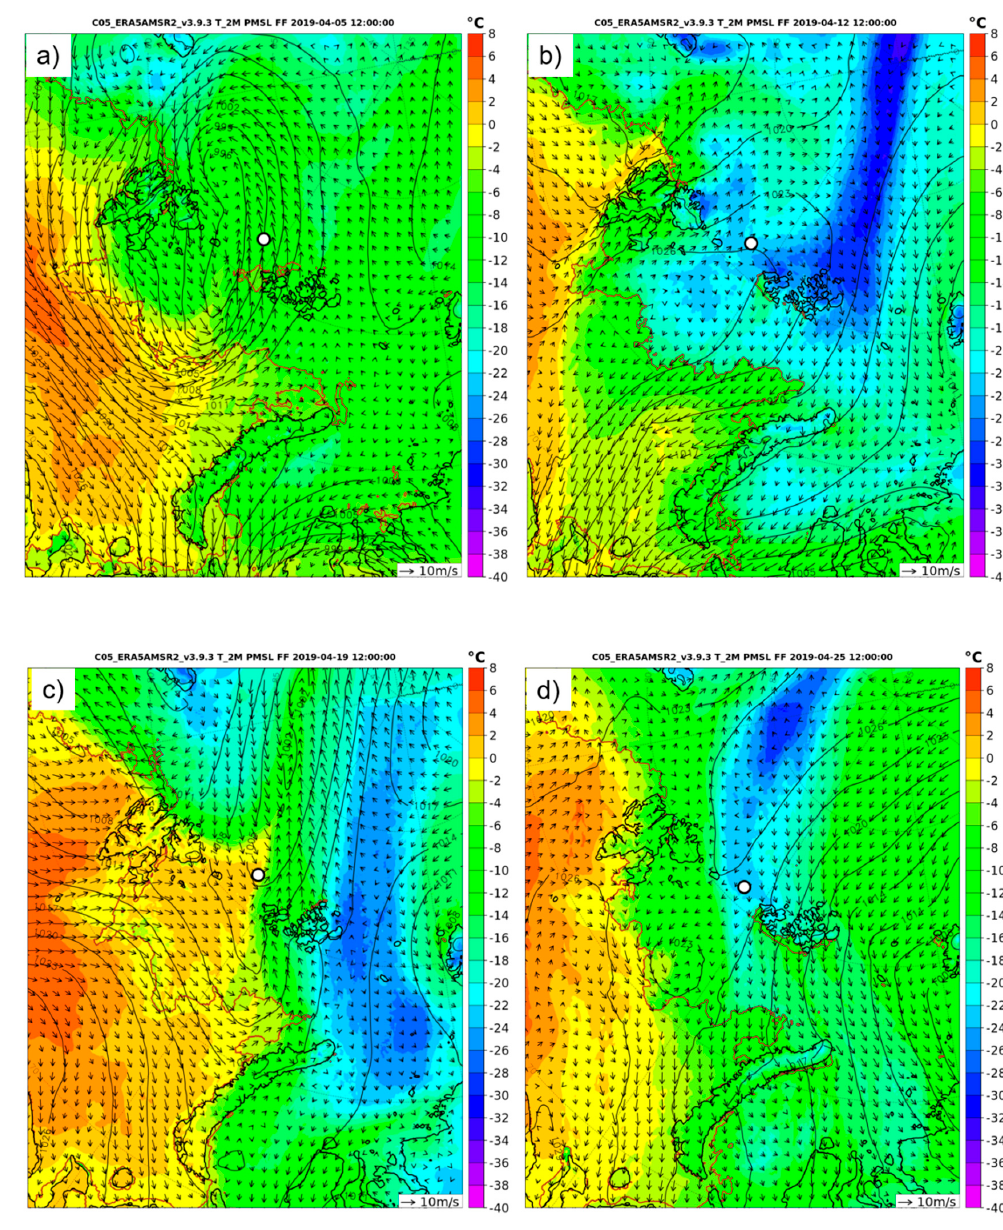
Figure 5. Fields of CCLM-simulated MSLP, 10 m wind and 2 m temperature at 12:00 UTC for ( a ) 5, ( b ) 12, ( c ) 19 and ( d ) 25 April 2019. The ship position is marked with a white dot (see also Figure 1).